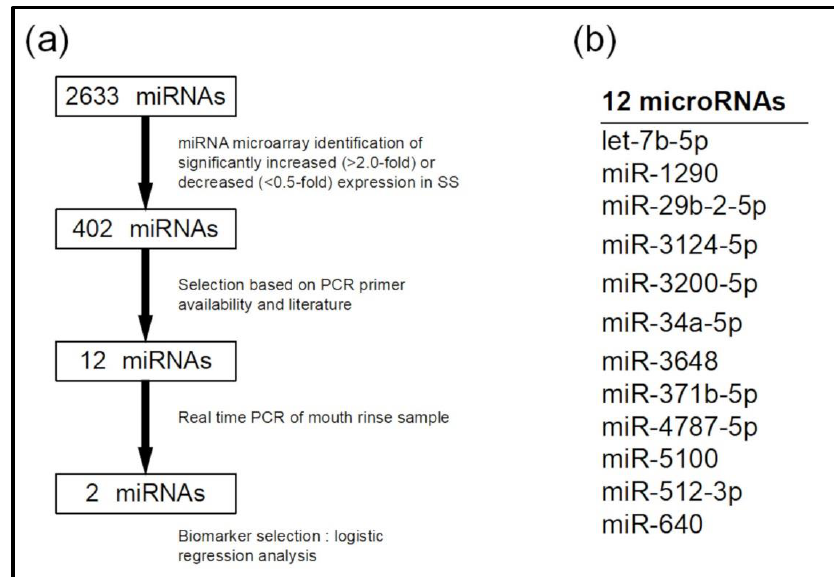
Figure 2. Selection of candidate microRNAs (miRNAs) using microarrays. ( a ) Flow diagram of candidate miRNA detection. ( b ) MicroRNAs validated using real-time PCR.